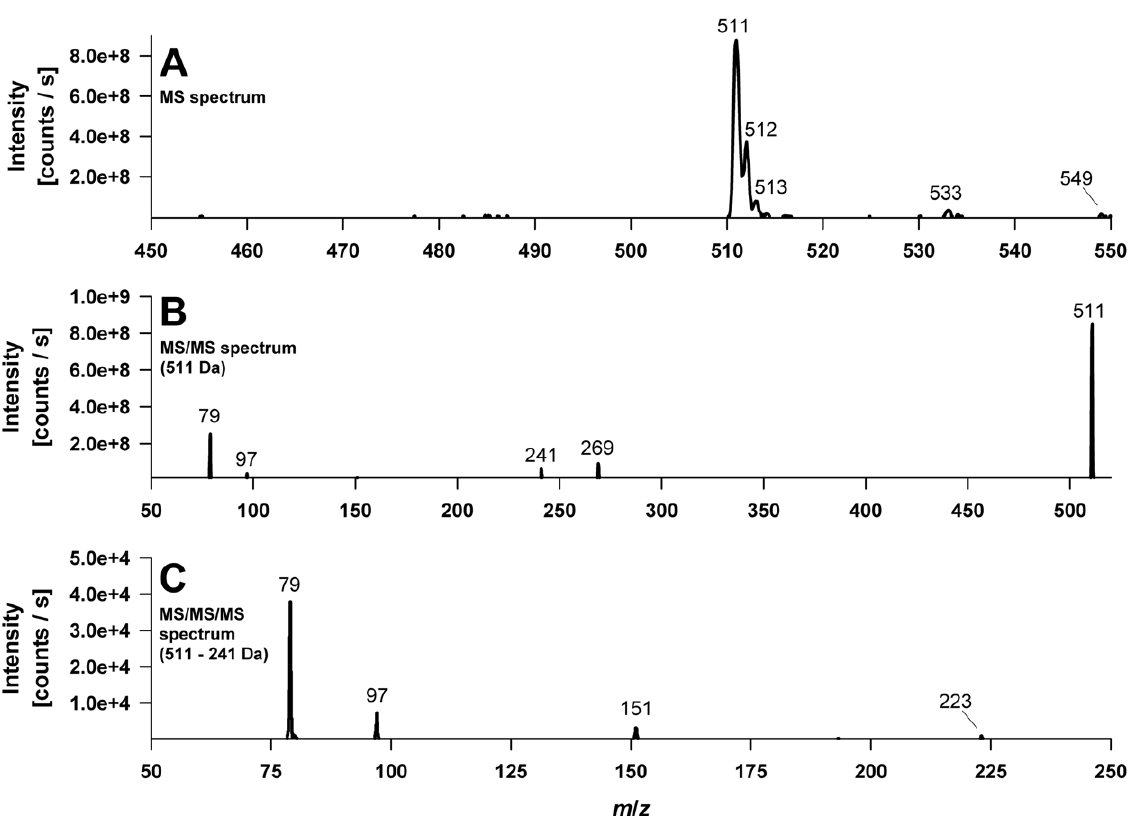
Figure 4. Electrospray mass spectra (QTrap system) of the deprotonated main genistein metabolite M5, identified as a genistein- monophosphoglucoside. (A) MS spectrum. (B) MS/MS spectrum of m/z 511. (C) MS/MS/MS spectrum of m/z 511 R m/z 241.